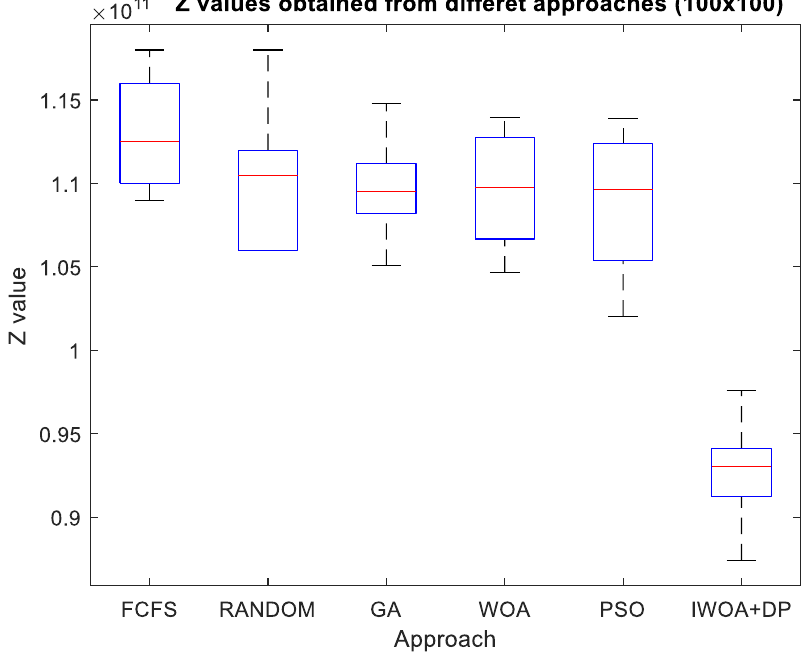
Figure 14. The box-whisker plot chart of Z values found for the problems (100 × 100).